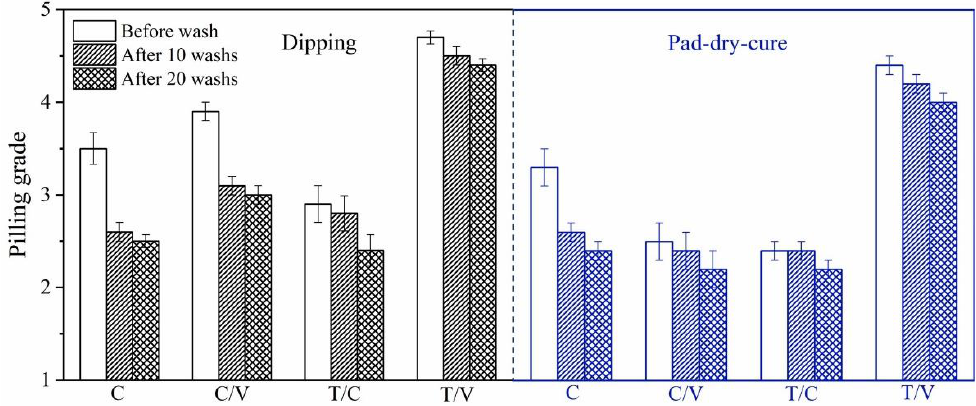
Figure 6. Pilling grade of treated fabrics before and after 10 and 20 washing cycles.